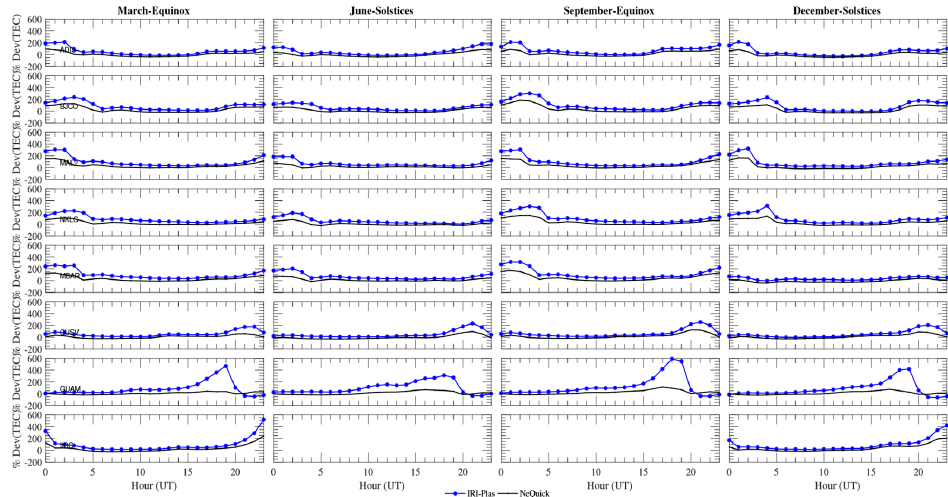
Figure 4. Monthly RMSDs for the year 2013 ( a ) and 2014 ( b ) for all the stations.